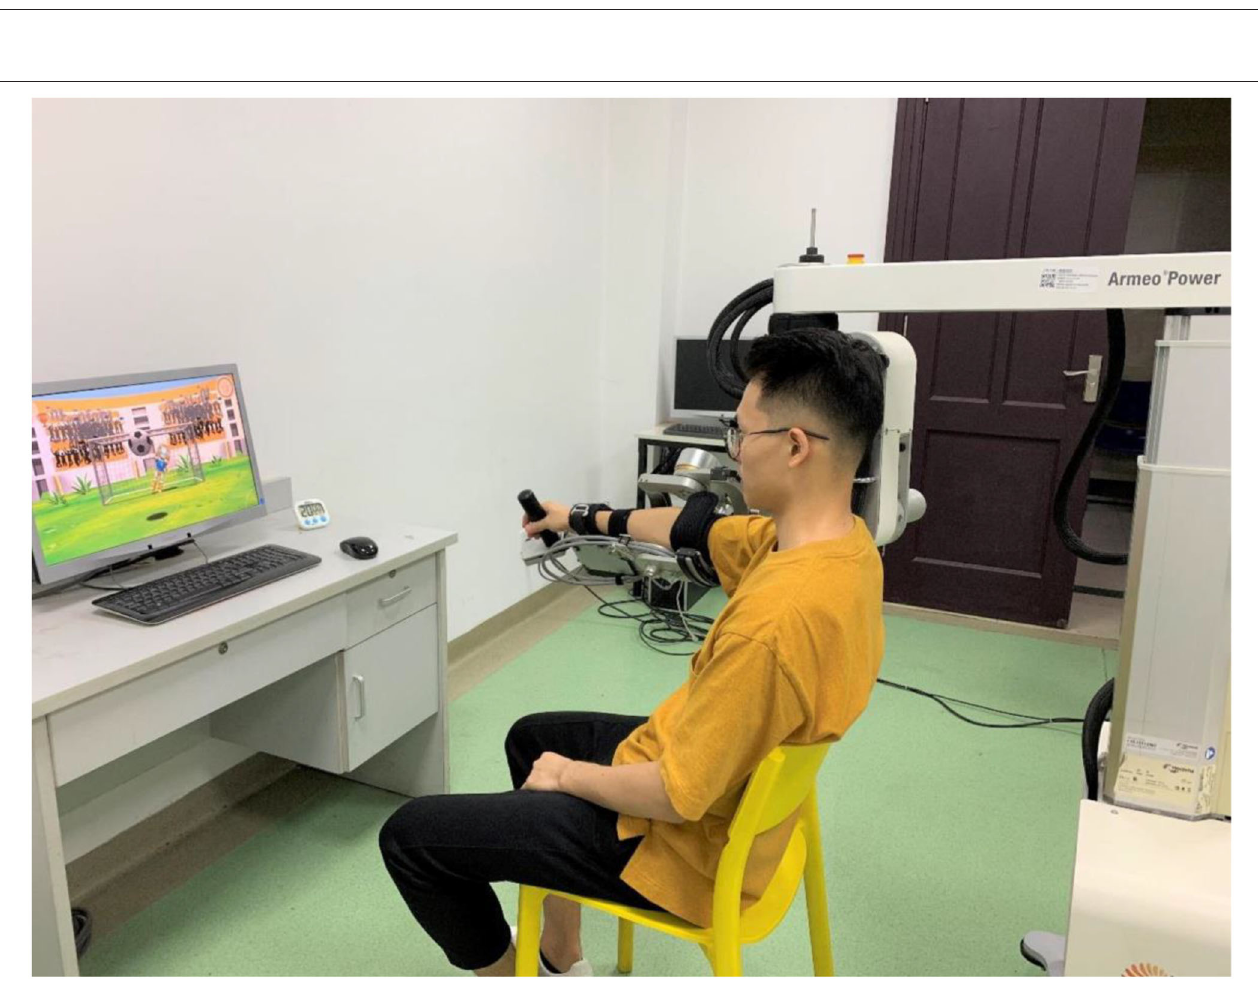
FIGURE 3 | The robotic system used in the study for upper limb rehabilitation.